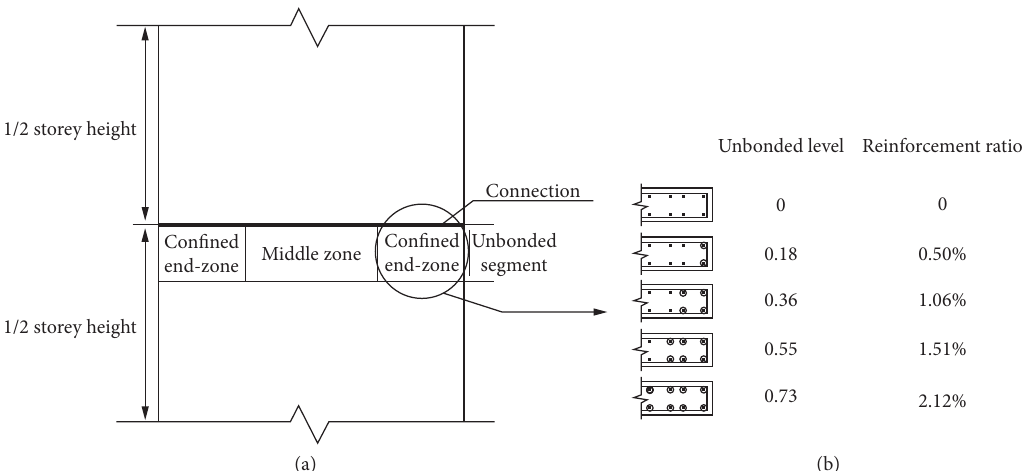
Figure 17: Division of unbonded region (a) and corresponding relation between unbonded level and reinforcement ratio of confined end- zone